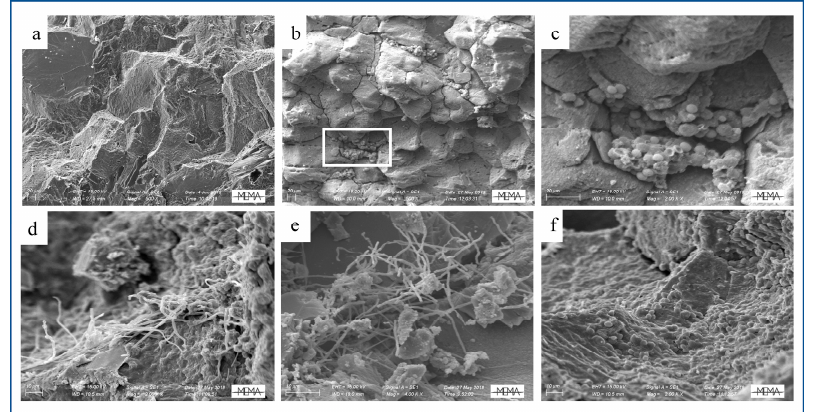
5 Figure 5. Scanning electron microscope images of SMFC marble. ( a ) NW sample (SMF1); ( b ) SE sample (SMF6), the grain detachment is clearly visible, colonies of unicellular cyanobacteria are scattered around the marble grains. ( c ) A detail of ( b ) (white rectangle), a colony with cells growing in the fissures among grains; ( d – f ) NW sample (SMF2), filamentous microorganisms connected through an EPS matrix to a multispecies biofilm adhering to marble ( d ), and detaching marble particulate ( e ). ( f ) Microbial biofilm completely covering marble surface with cells embedded within the EPS